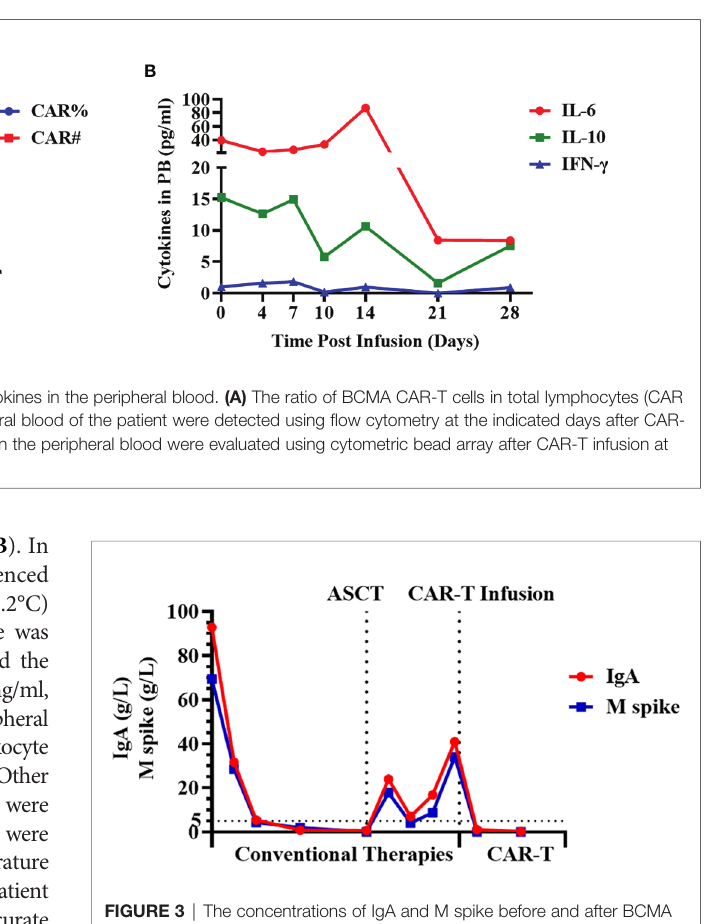
FIGURE 3 | The concentrations of IgA and M spike before and after BCMA CAR-T cell